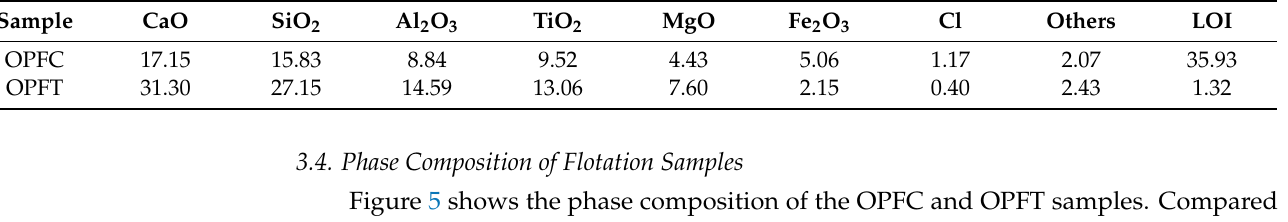
Figure 4. Effect of frother dosage on the flotation performance of FEBFS samples. ( a ) yield of flotation product and ( b ) LOI of flotation product.